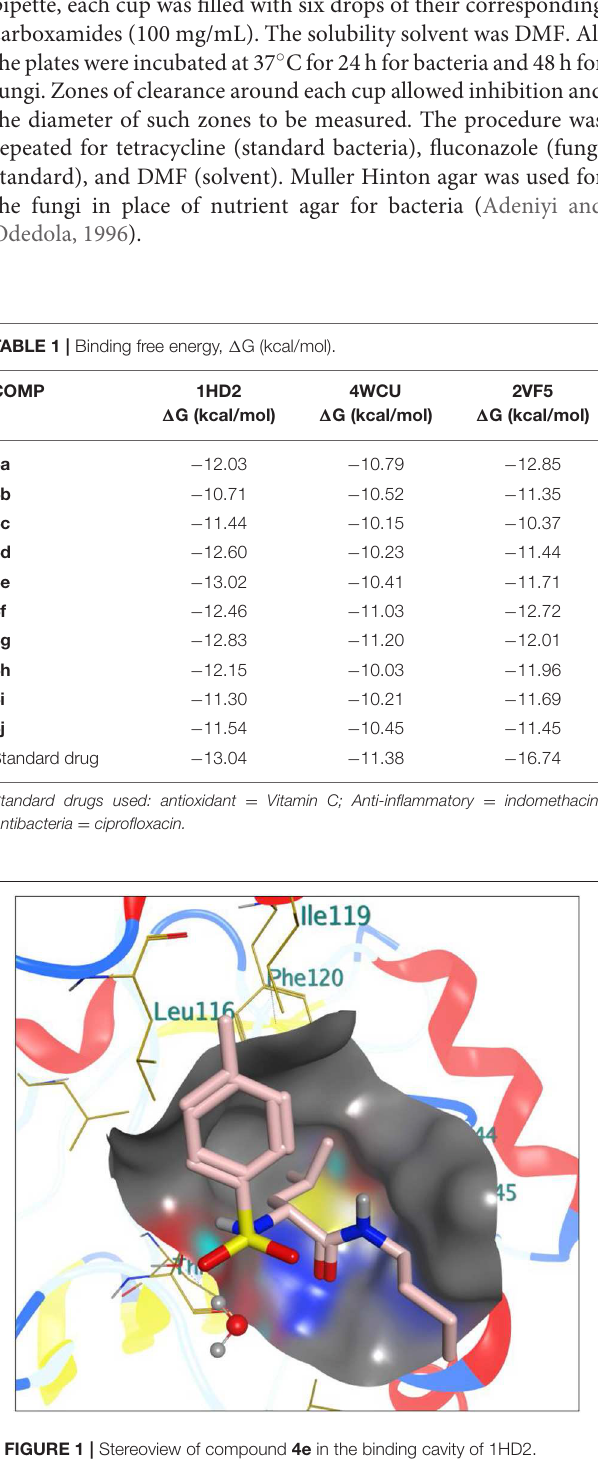
FIGURE 1 | Stereoview of compound 4e in the binding cavity of